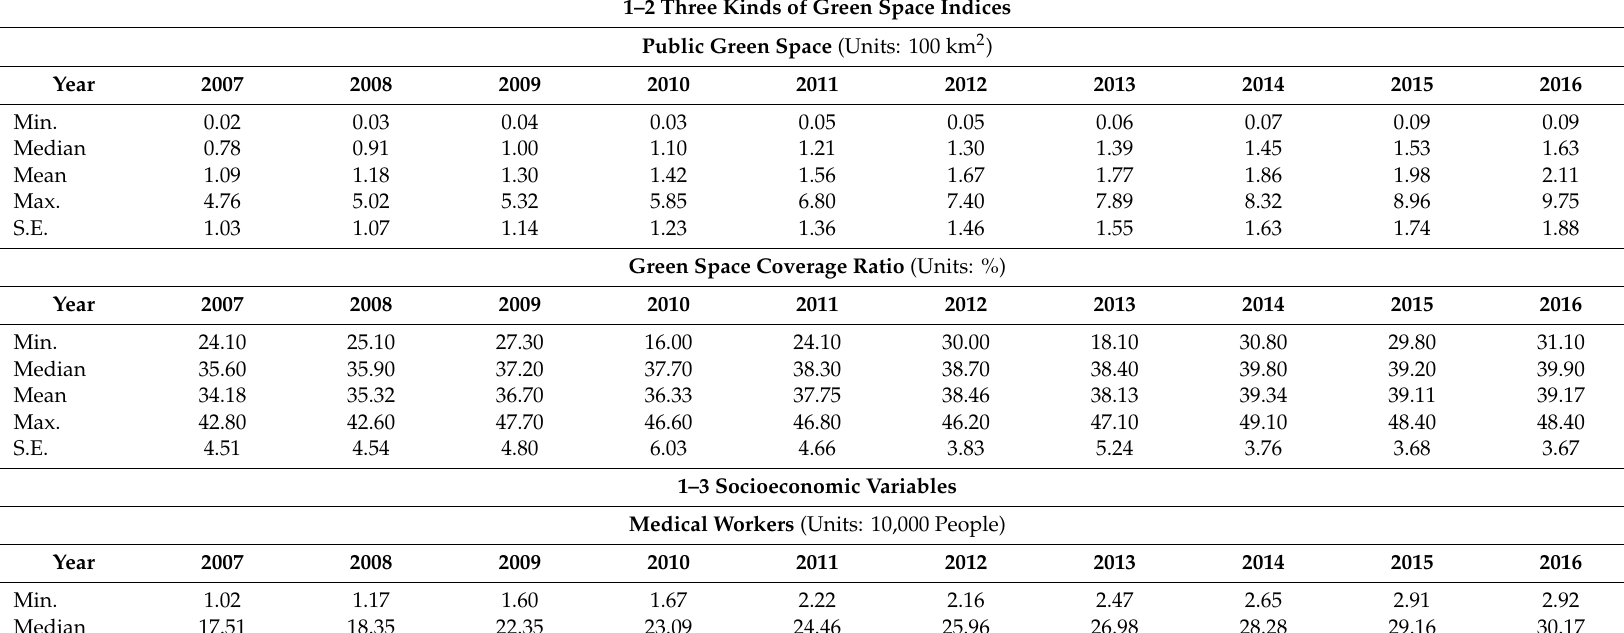
1–2 Three Kinds of Green Space